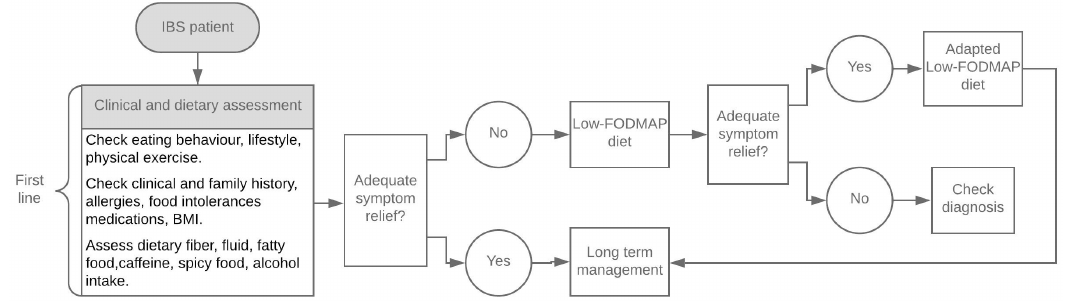
Figure 1. Dietary management algorithm in irritable bowel syndrome (IBS), modified from McKenzie YA, 2016 [12].